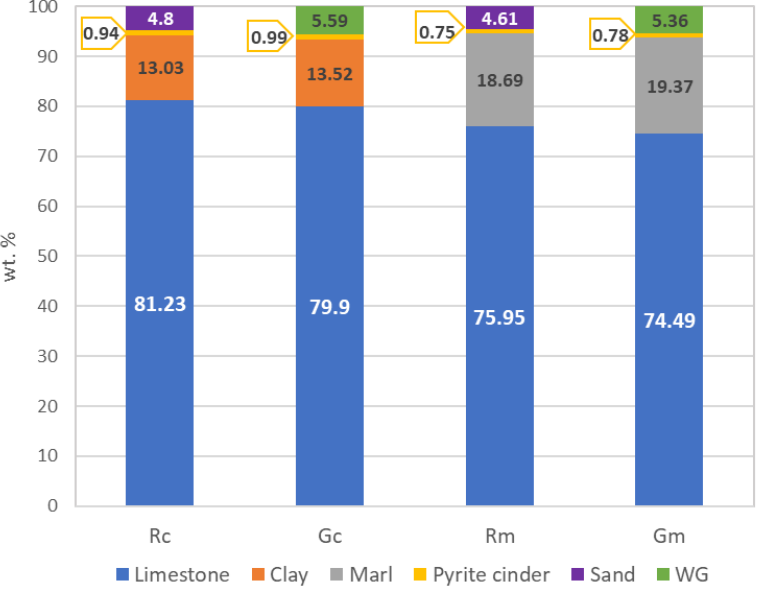
Figure 2. Composition of raw mixes used for clinker and cement manufacture.